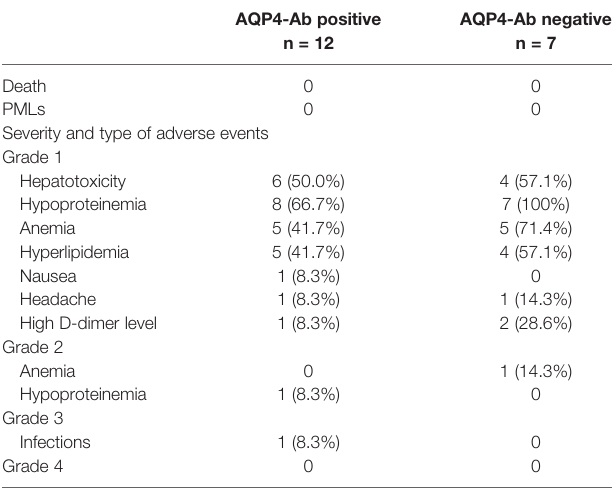
TABLE 2 | Adverse events during tocilizumab treatment in patients with neuromyelitis optica spectrum disorder (NMOSD). AQP4-Ab positive AQP4-Ab negative n =